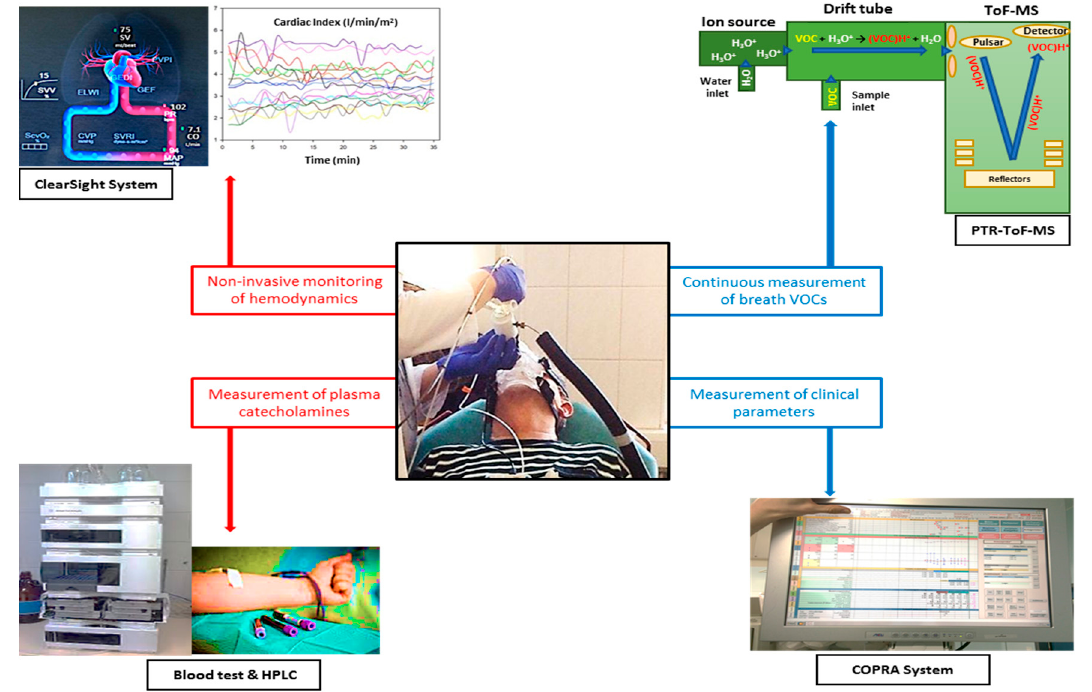
Figure 2. This figure summarizes the used equipment during the study. Patients’ characteristics and clinical data as well as hemodynamic parameters were obtained from our digital data management program COPRA. VOCs were measured using direct real-time proton transfer reaction time-of-flight mass spectrometry (PTR-ToF-MS) analysis. Blood samples were taken to determine catecholamine levels in plasma prior and after analgesic treatment and were subsequently analyzed using High-Performance Liquid Chromatography (HPLC). Hemodynamic variables were measured using noninvasive finger cuff-derived pulse wave analysis (ClearSight EV 1000).